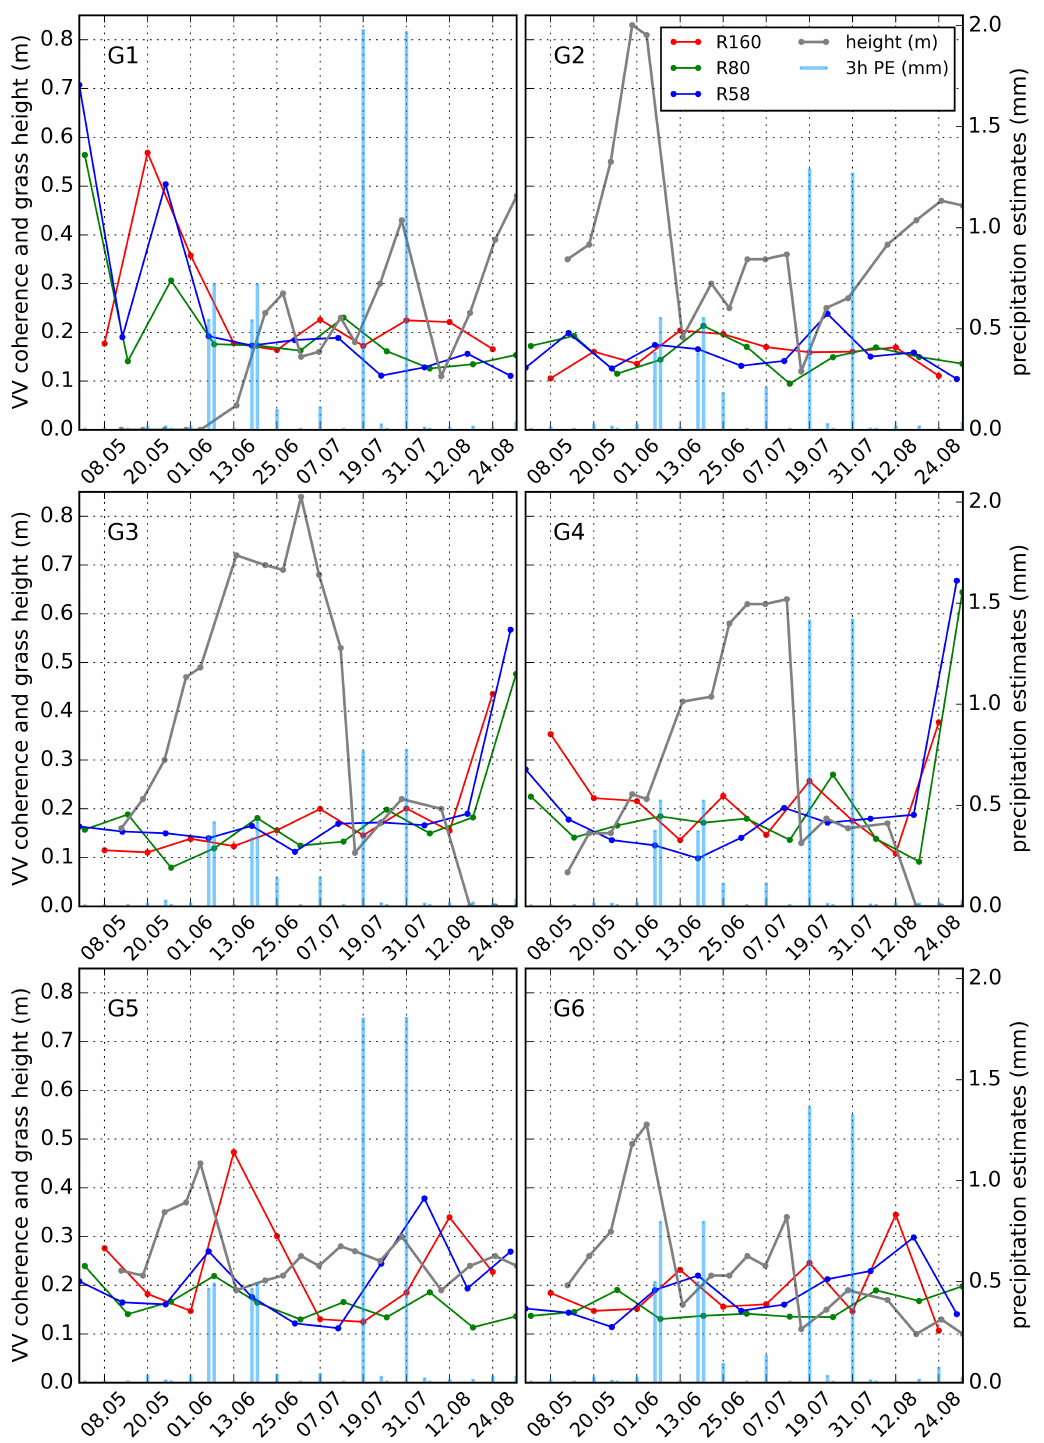
Figure 3. The 2015 time series of recorded height and coherence values for grasslands where the field survey was conducted. Polarization is vertical transmit, vertical receive (VV). Date of the first image of the coherence pair is given on the x -axis. Vertical blue lines indicate the sum of 3-h precipitation estimates (PE) in mm for the image